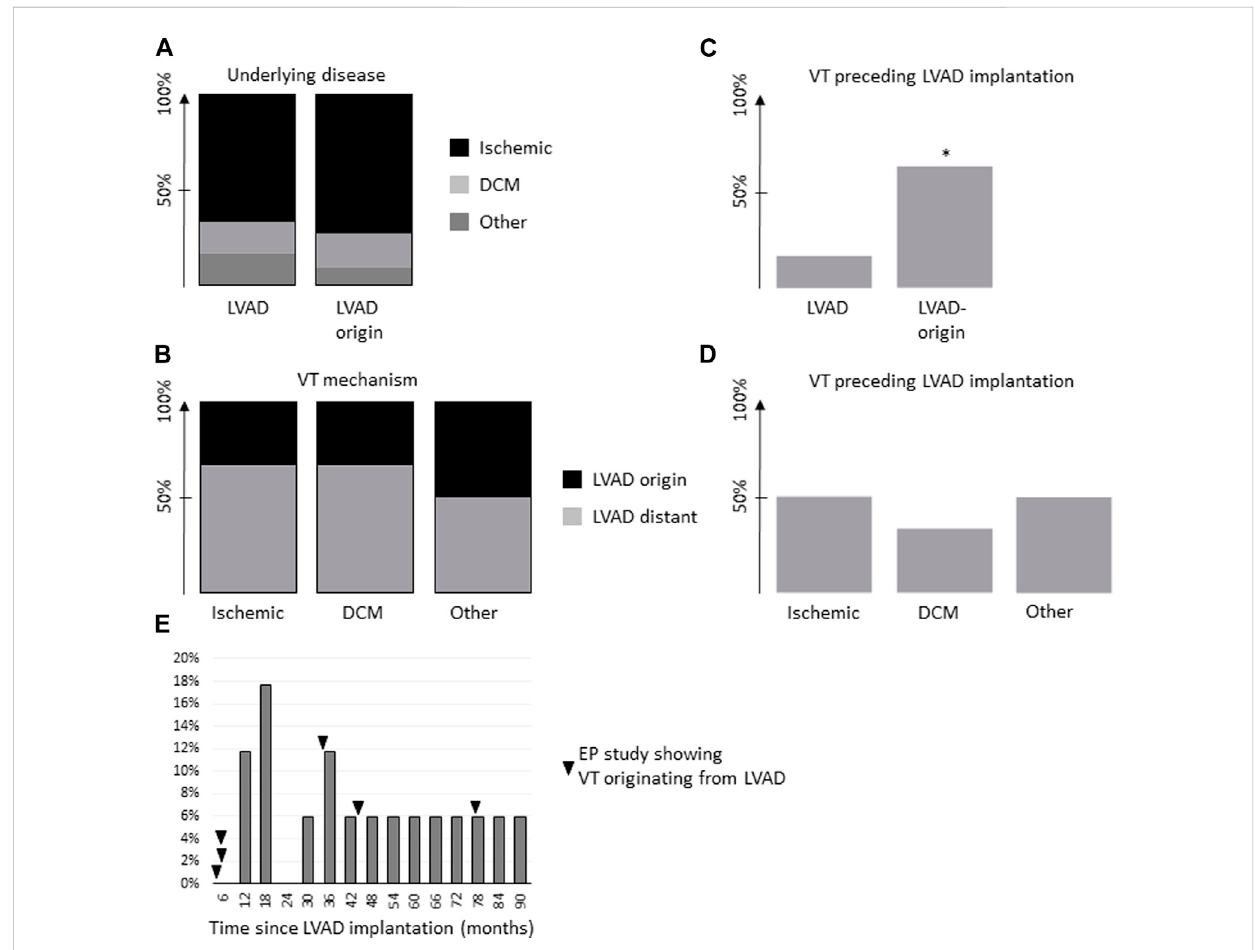
FIGURE 2 (A) . Underlying disease inpatients with VT (VT) that was determined to beLVAD associated ( “ LVAD ” ) or not LVADassociated ( “ LVAD-distant ” ). (B) . VT mechanism, i.e., ischemic, non-ischemic dilatative cardiomyopathy (DCM) or other in relation to the respective VT - LVAD association. C and (D) . Percentage of patients with VT preceding LVAD implantation in relation to their respective VT – LVAD association (C) or underlying disease entity (D) . (E) . Histogram of time since LVADimplantation for all patients atend of follow-up. Time-pointsof EP cases with LVAD associated VT as indicated (black arrow). * p < 0.05 for non-LVAD-association of